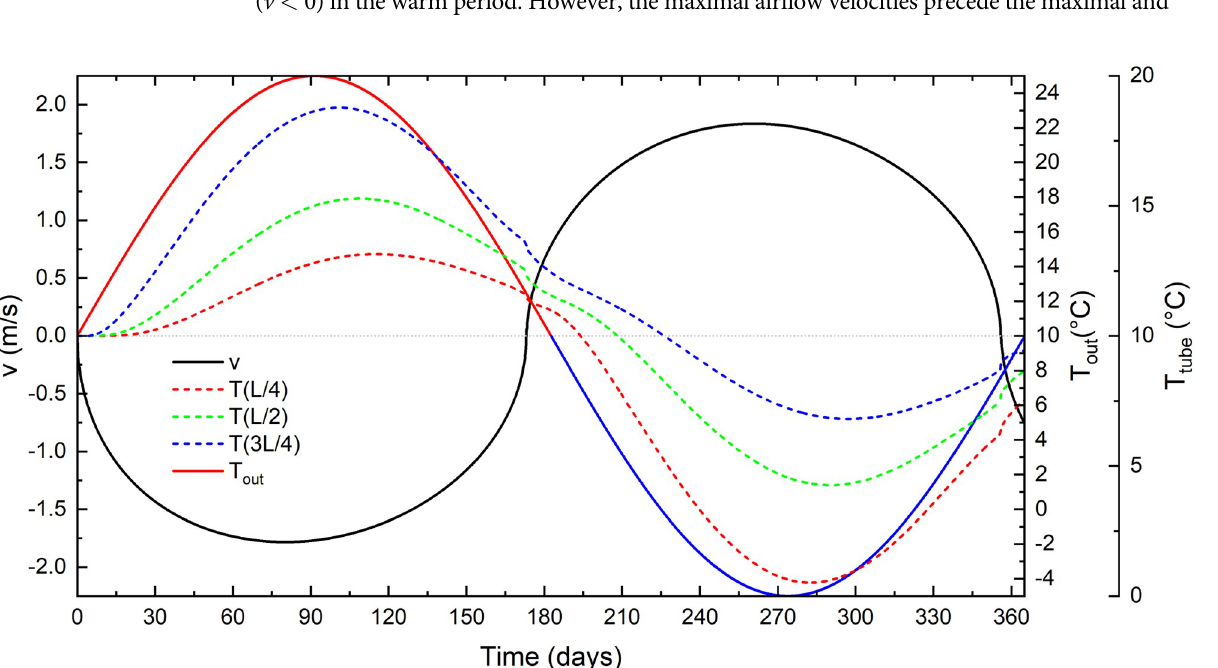
Fig 8. Outside temperature (blue/red), airflow velocity (black) and air temperatures (dashed) at L /4, L /2 and 3 L /2 for the standard case with periodic outside temperature.